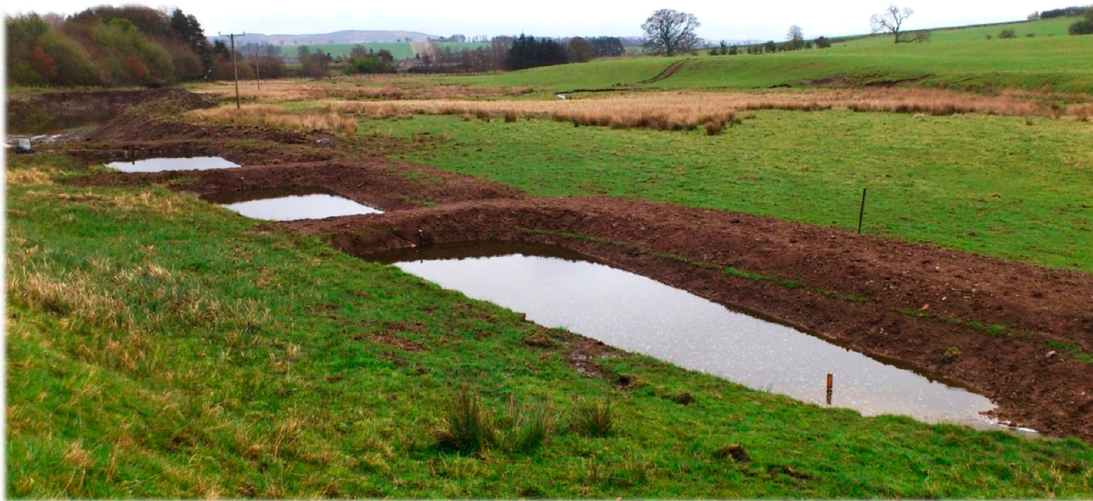
Figure 3. An example of a modified ditch with flow barriers acting as both a sediment trap and flood flow storage in Netherton Burn (photo from Barber 2013, credit to N. Barber).